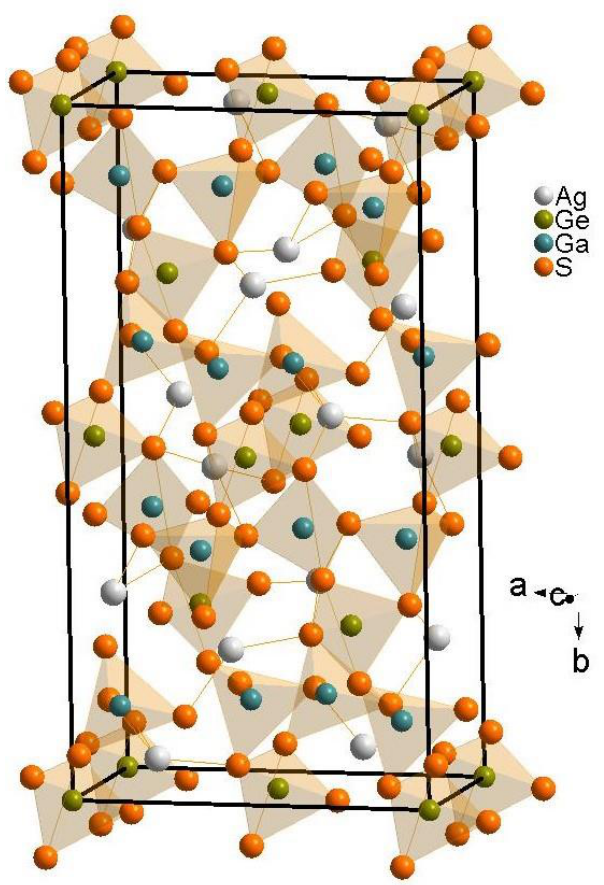
Figure 2. Crystallographic unit cell of AgGaGeS 4 under the assumption of fixed occupancy of cations through the lattice, with Ga and Ge occupying 8a and 16b crystallographic sites, respec- tively.